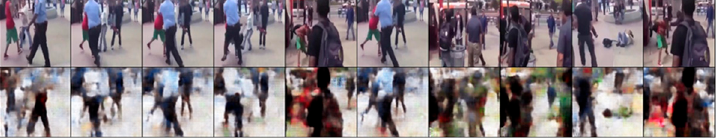
Figure 10. Reconstruction effect of the encoder–decoder network.